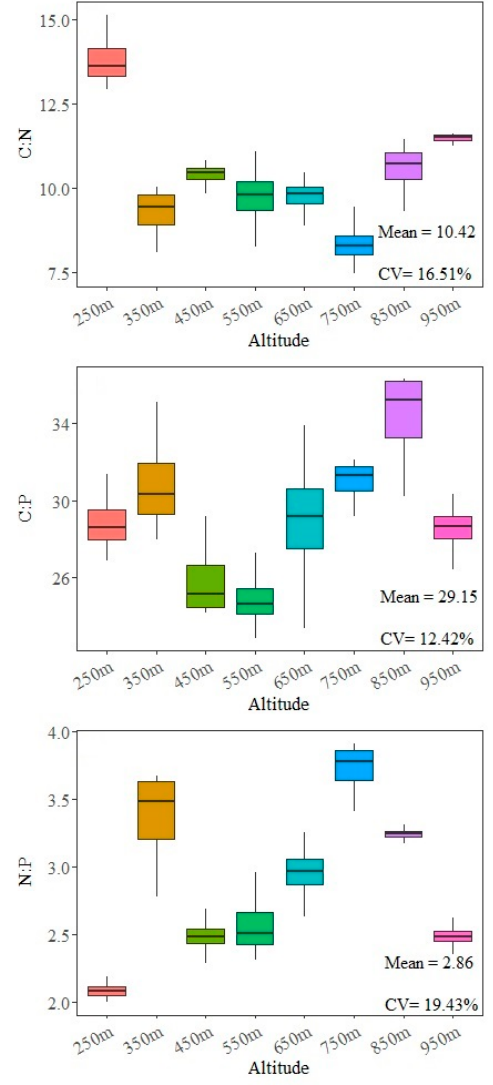
Figure 3. Soil ecological stoichiometric characteristics along the altitudinal gradient.